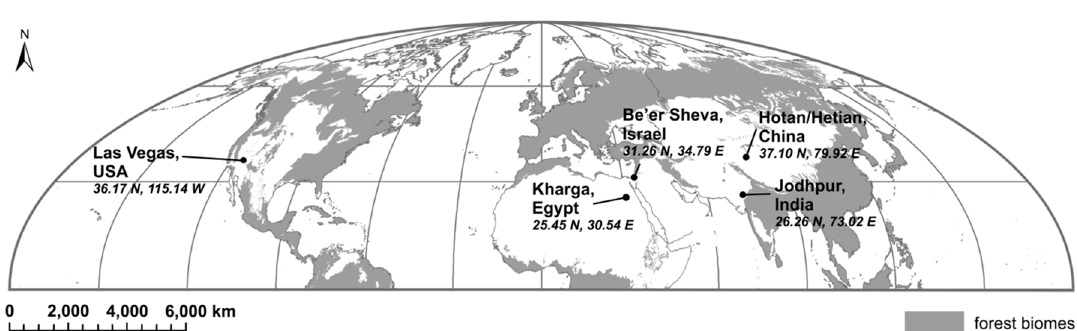
Figure 1. Locations of the five subtropical desert cities: Beer Sheva, Israel; Hotan, China; Jodhpur, India; Kharga, Egypt; Las Vegas, NV, USA.